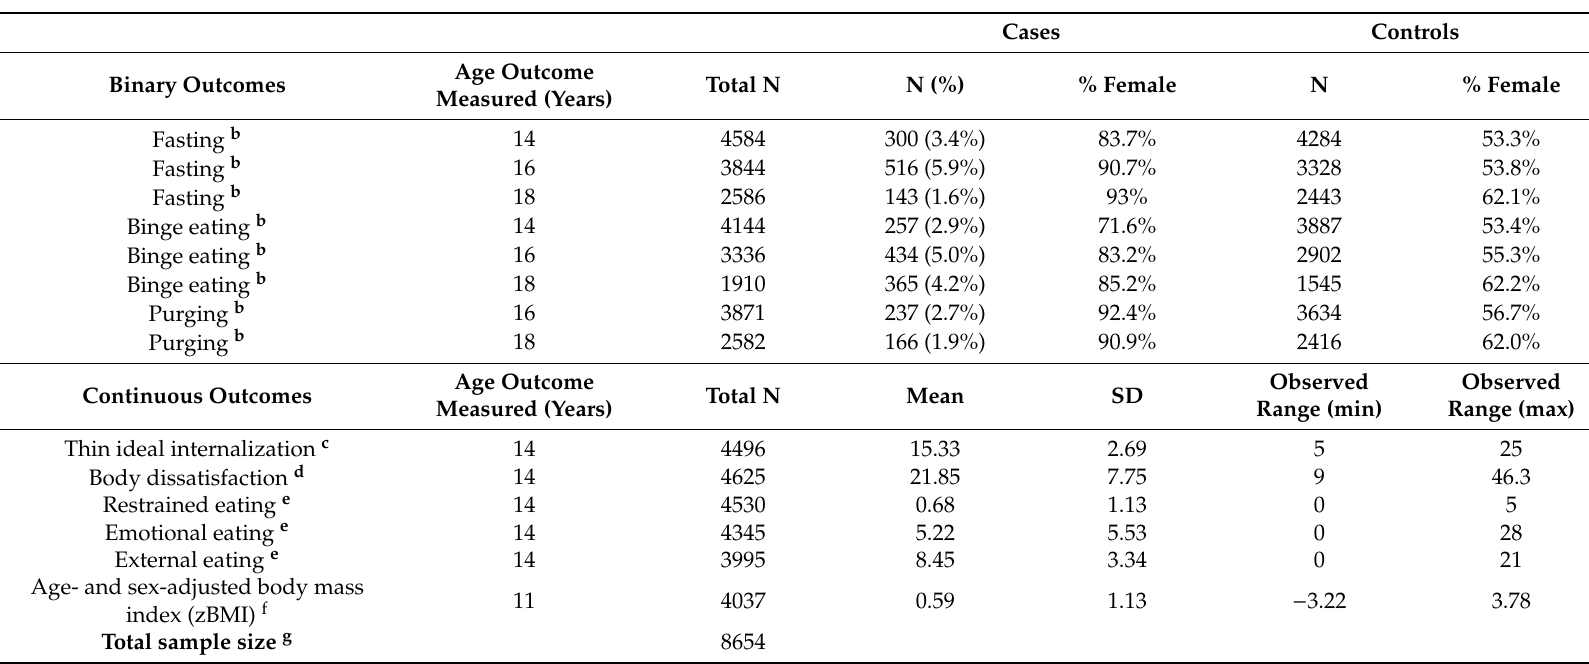
Table 1. Descriptive statistics of disordered eating behaviors and cognitions and BMI of the participants in the Avon Longitudinal Study of Parents and Children a.